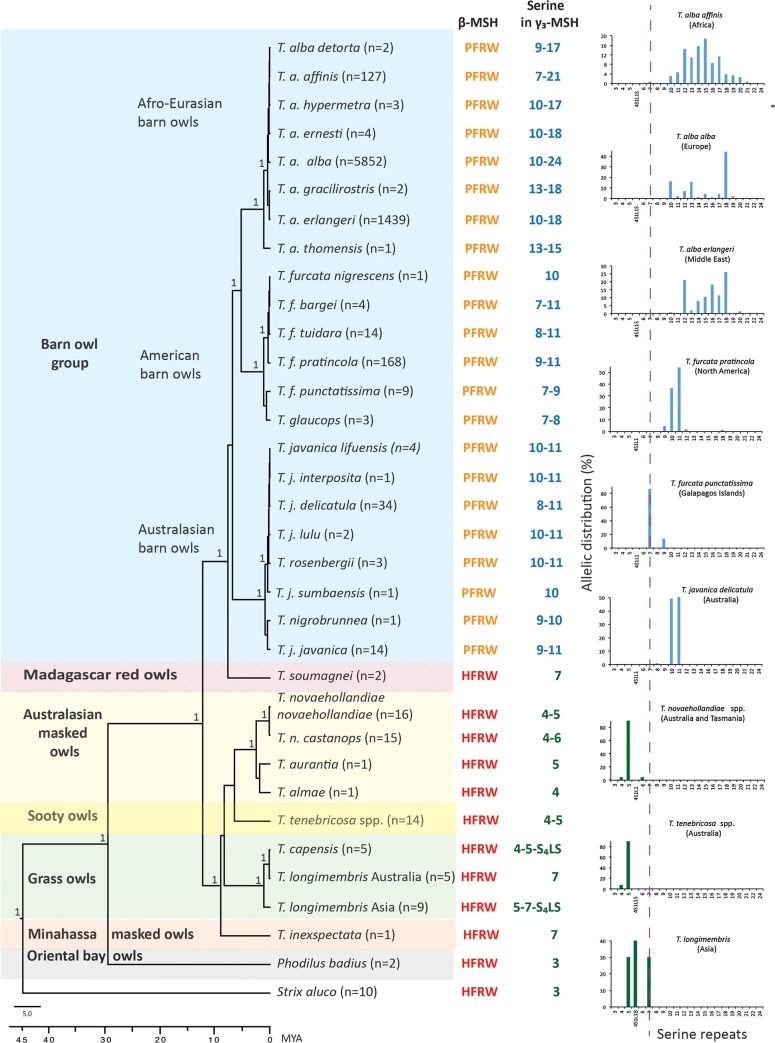
Molecular phylogeny of the Tytonidae family, polymorphism in β-MSH at the receptor-binding site (ancestral HFRW or mutated PFRW), and number of serine repeats in γ3-MSH.Tytonidae taxa homozygous for HFRW are written in red and taxa carrying the homozygous mutation PFRW are written in orange. The range of the number of serine repeats is indicated in blue when ≥ 7 and in green when ≤ 7 and N indicates the number of sequenced individuals. For taxa with a large number of individuals sequenced, we report the distribution of the number of serine repeats. In the phylogenetic tree, 1 indicates that the node has a posterior probability of 1 (= 100%) and the time unit is million years (MYA).